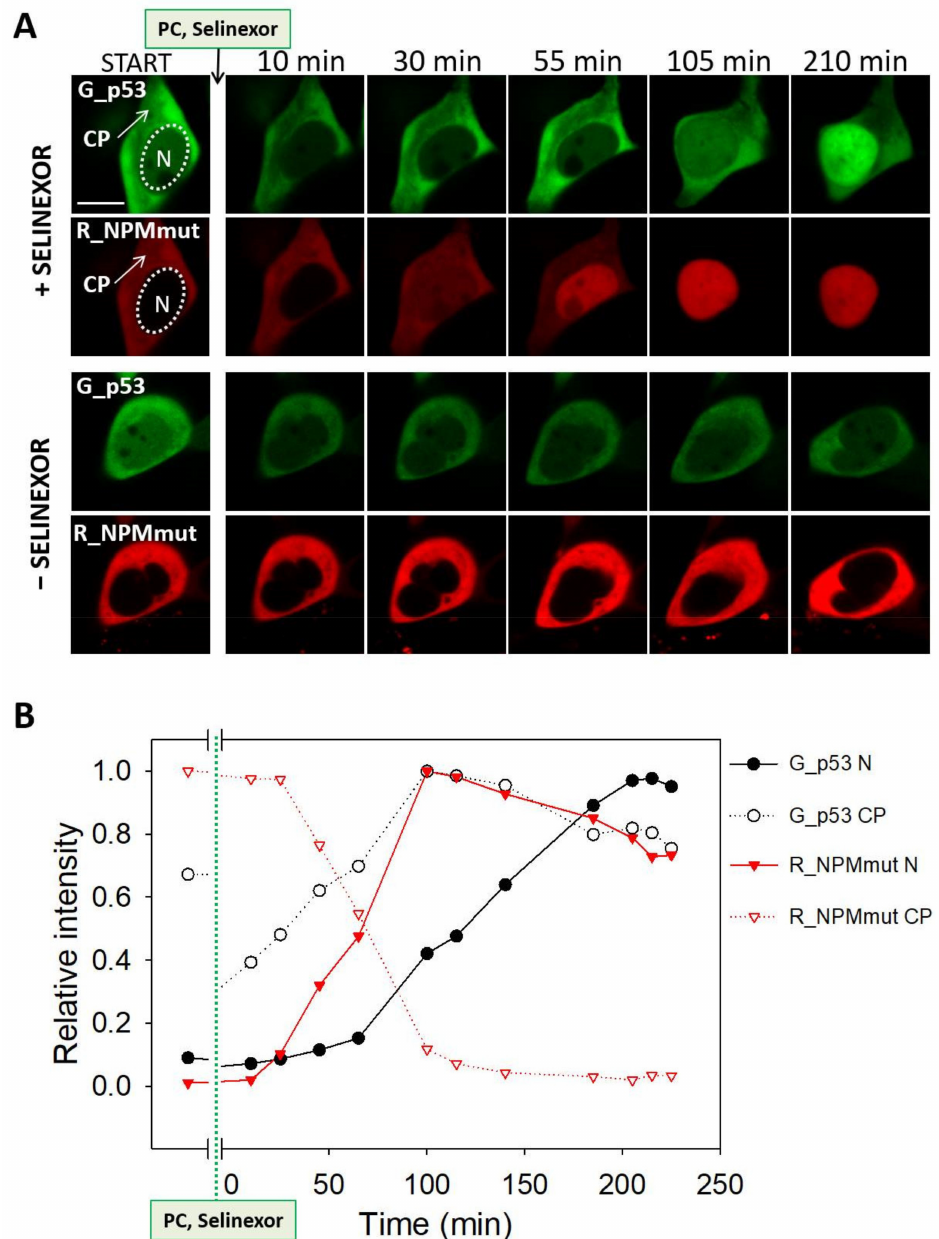
Figure 8. Effect of Selinexor on the fluorescence intensity and localization of G_p53 and R_NPMmut co-transfected in HEK-293T cells. ( A ) Intensity images of G_p53 co-expressed with R_NPMmut at different times upon the addition of 4 µ M Selinexor (upper two rows, cell no. 1). The control experiment without Selinexor is presented in the lower two rows (cell no. 4). Depicted are cells from Figure 7B. Bar represents 10 µ m; ( B ) fluorescence intensity changes of G_p53 (circles) and R_NPMmut (triangles) in the nucleus (close symbols, full lines, N) and the cytoplasm (open symbols, dash lines, CP) of the cell from the upper two rows of the panel A. Areas used for integration of the fluorescence signal are separated by the dotted line in panel A. The initial irreversible photoconversion (PC) of G_p53 reduced eGFP intensity to about 45% of its initial value before the addition of Selinexor (open circles). List of abbreviations is in Table 1. Representative results from 3–5 repeated experiments are